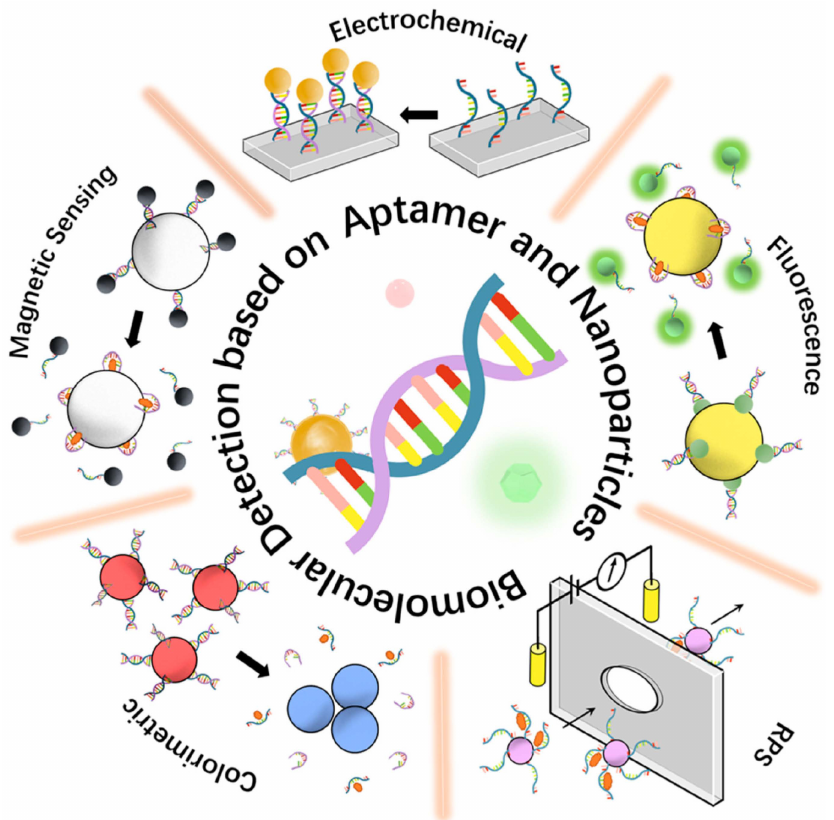
Figure 1. Schematic overview of different mechanisms of nanoparticle–aptamer-based biomolecular detection.